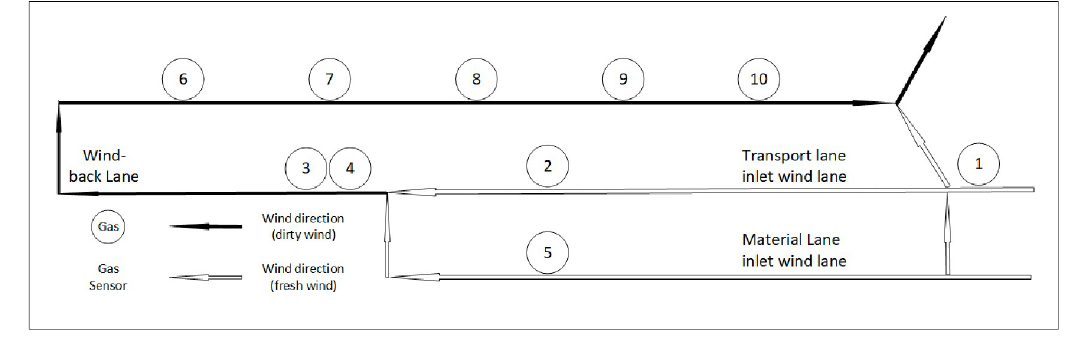
Fig 2. Ten gas sensors installed in Case Study mine 1.